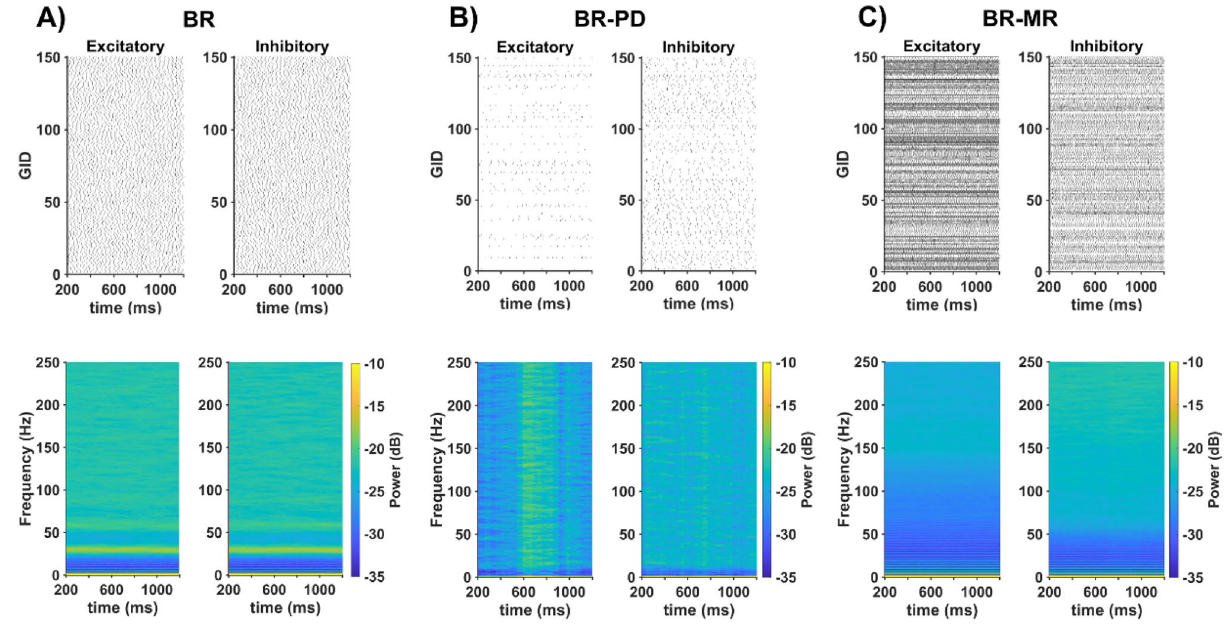
Figure 3. Network behaviors for different connectivity. Panels illustrate the raster plots of 150 randomly chosen neurons denoted by their GID (a unique number associated to each neuron) (top), and the corresponding power spectra (bottom) during a simulation with the same random background activity. ( A ) A 12,500-neuron network connected as in BR 14 , ( B ) connected as in PD 33 with 30,000 neurons, ( C ) connected as in MR 30 with 30,000